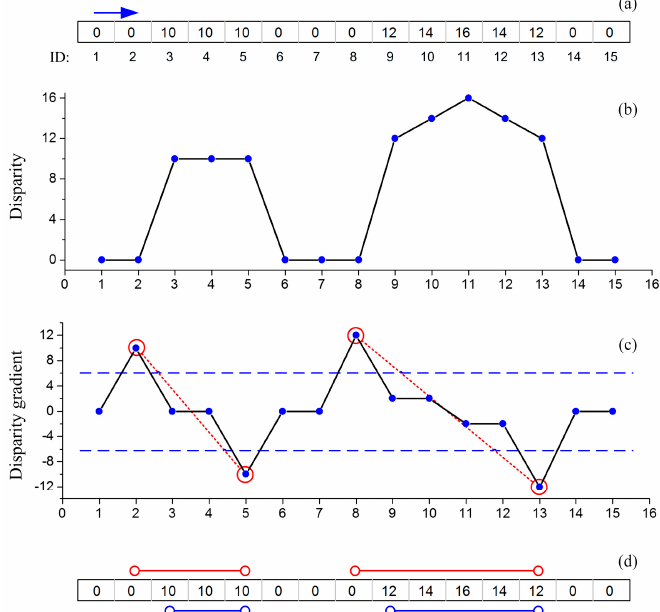
Figure 5. Obtaining Interesting Line Segments (ILSs) in a Profile Line (PL). ( a ) PL with disparity values. ( b ) Disparity profile. ( c ) Profile of disparity gradient calculated with the displacement vector (1, 0). ( d ) PL with obtained ILSs.